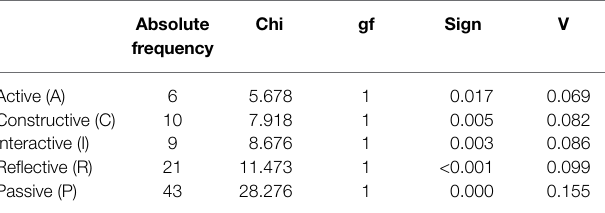
TABLE 6 | Co-occurrence of ICAP + R and the sub-category ‘support